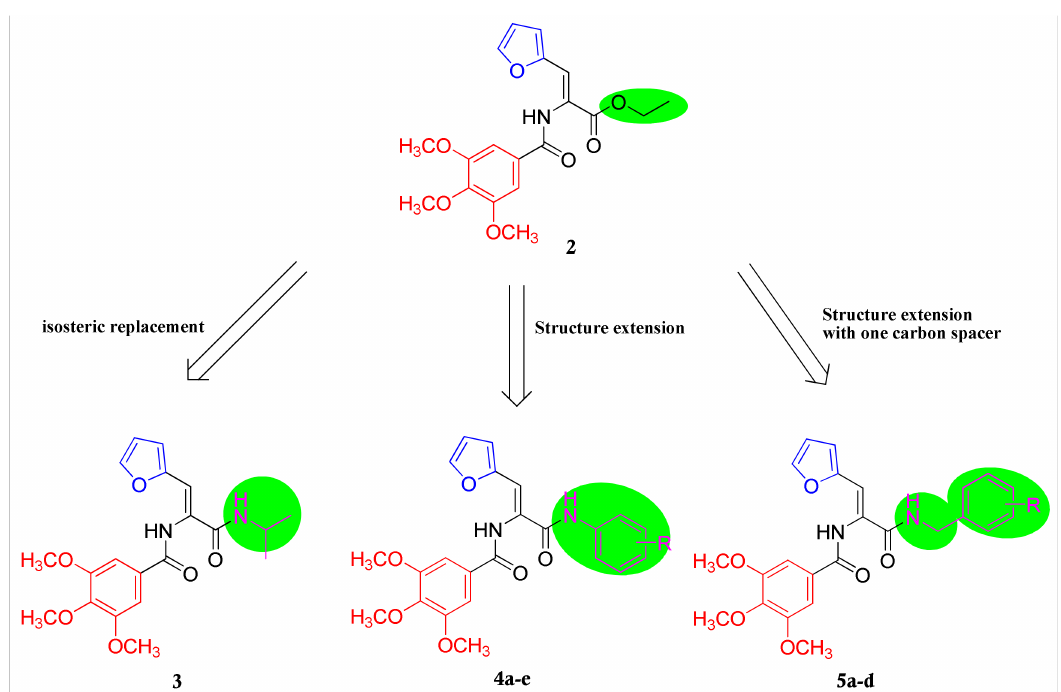
Figure 2. Design of the target anticancer acrylamide derivatives 3 – 5d